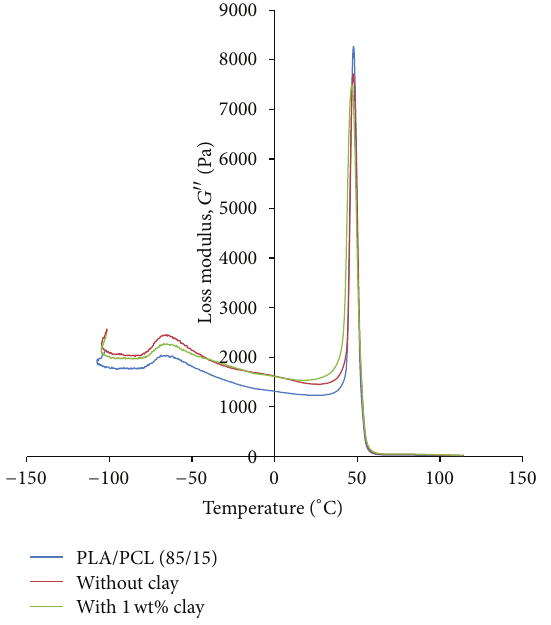
Figure 6: Loss modulus of PLA/PCL/OPMF biocomposites and PLA/PCL/1wt% clay/OPMF hybrid composites.